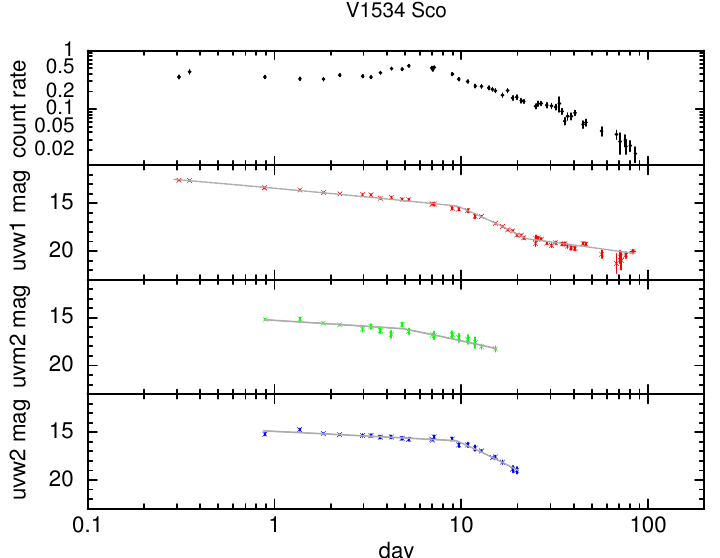
Figure 9. The XRT and UVOT light-curves of V1534 Sco, with the best-fit broken power-law declines shown as the grey solid lines. The X-ray data (top) are in count s − 1 over 0.3–10 keV.